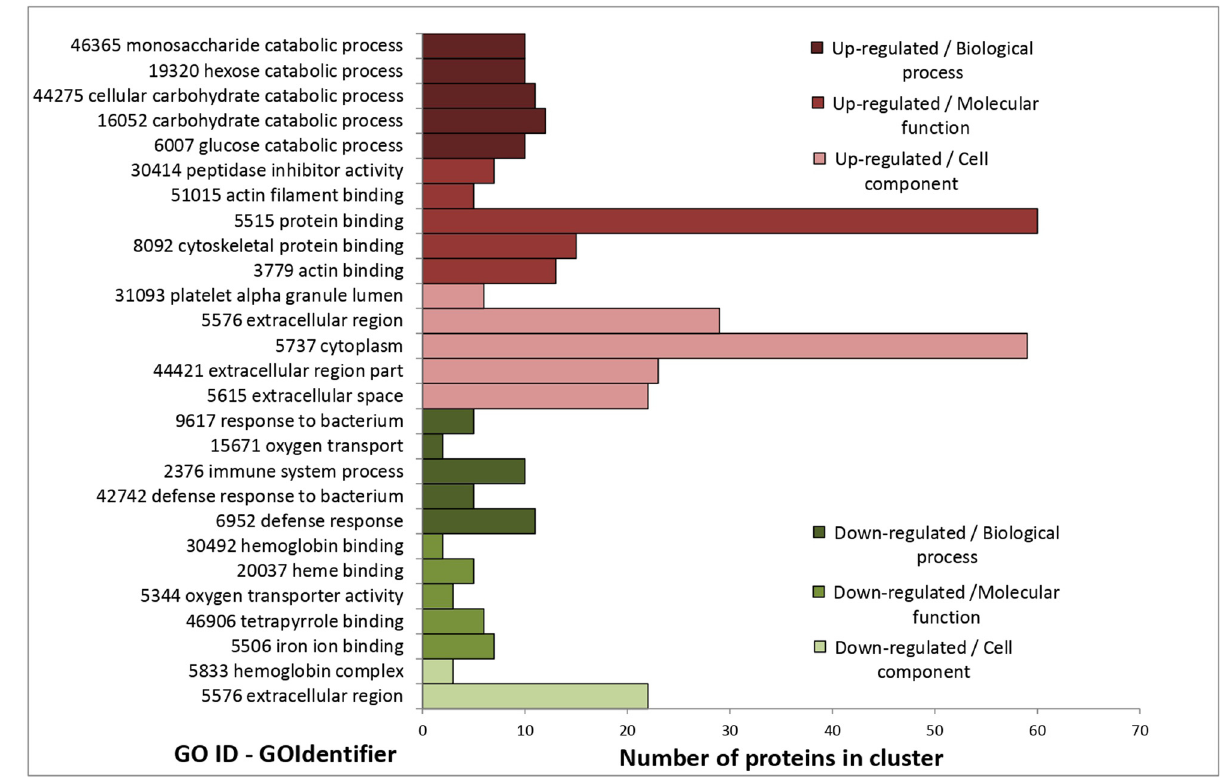
Figure 2: Gene ontology analysis of DEGs of three ontologies: biological process, molecular function, and cell component. The x - axis represents the number of up/downregulated genes/proteins. The y - axis represents the GO